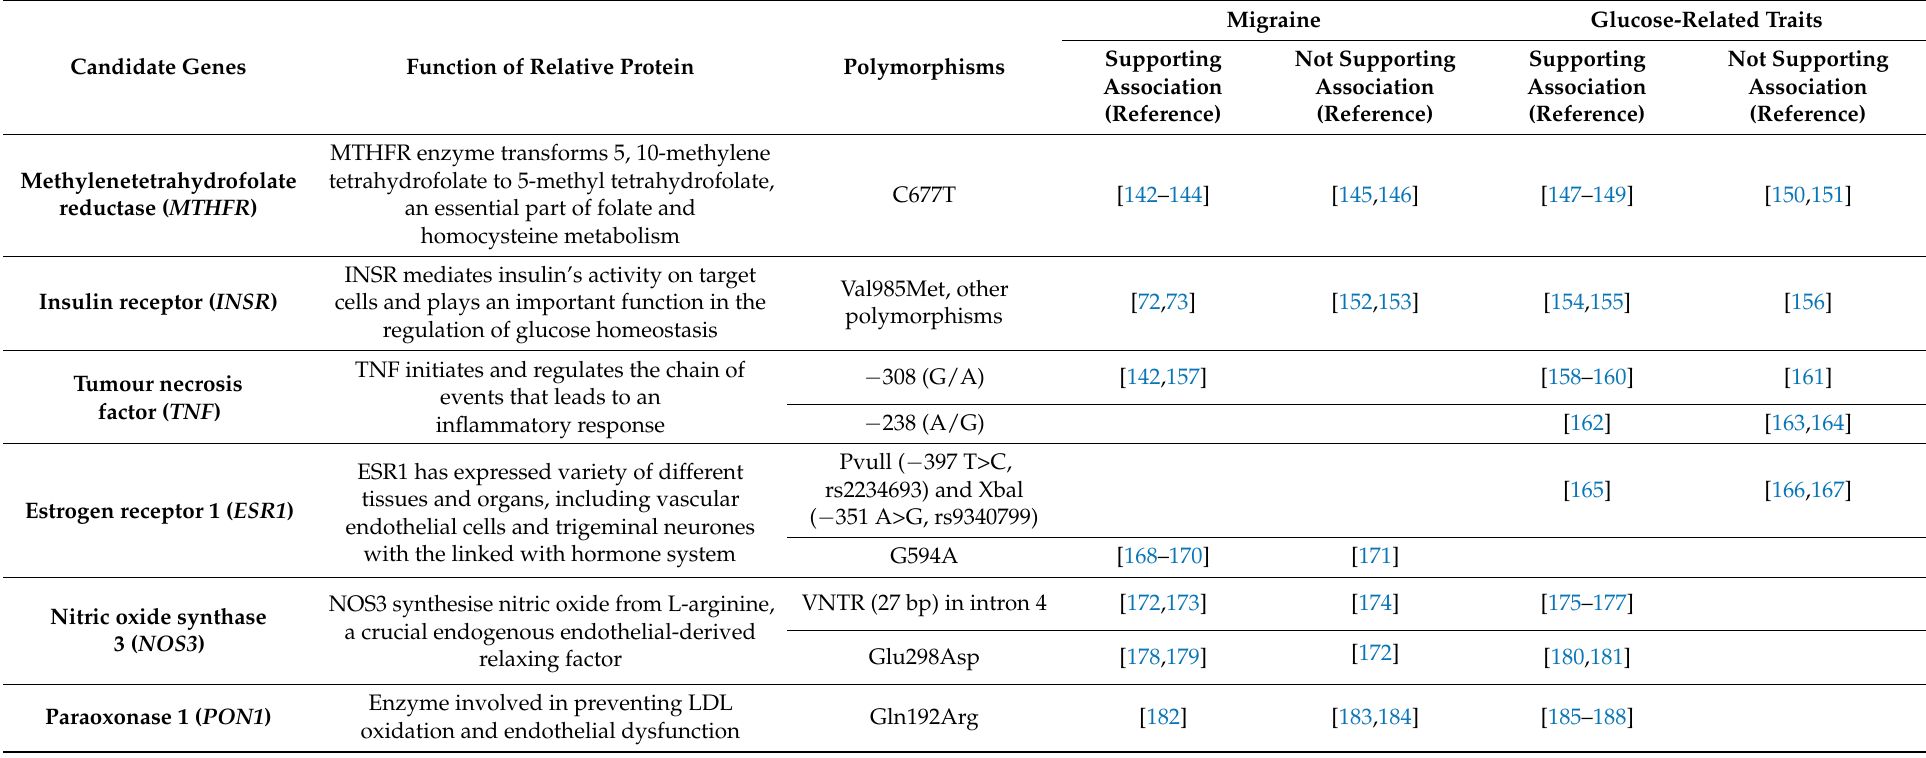
Table 1. A summary of candidate genes commonly associated with both migraine and glucose-related